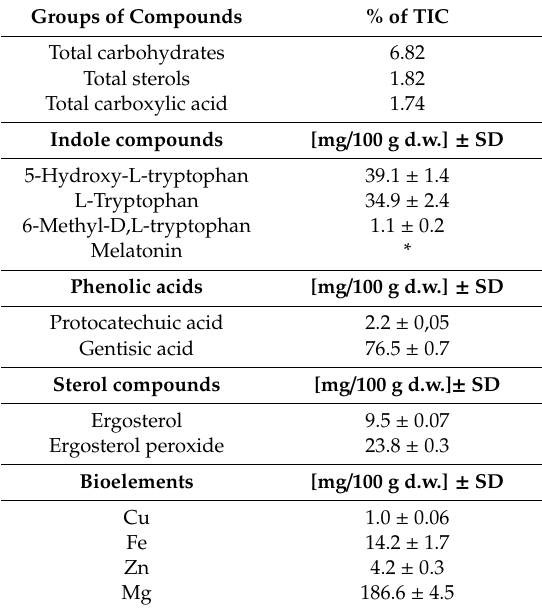
Table 1. Content of selected organic compounds and bioelements in Heterebasidion annosum fruiting bodies based on the results from GC-MS, HPLC, and F-atomic absorption spectroscopy (AAS) analysis. TIC–total ion current; d.w.–dry weight Groups of